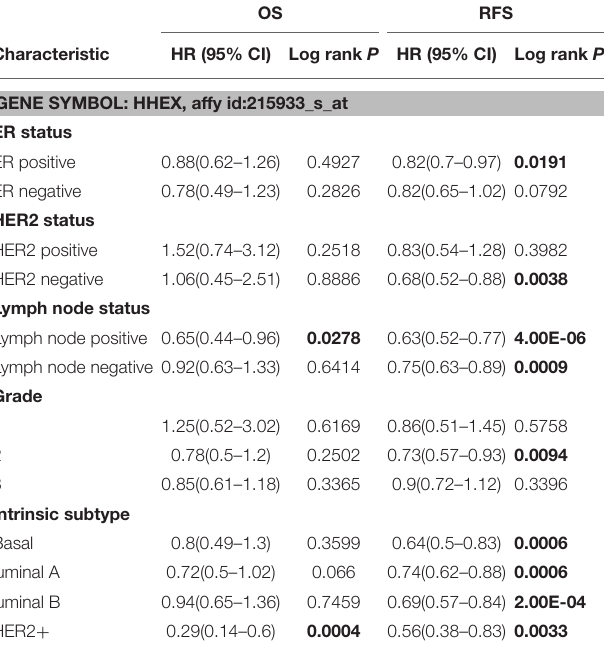
TABLE 3 | Correlation between HHEX expression and clinicopathological features.